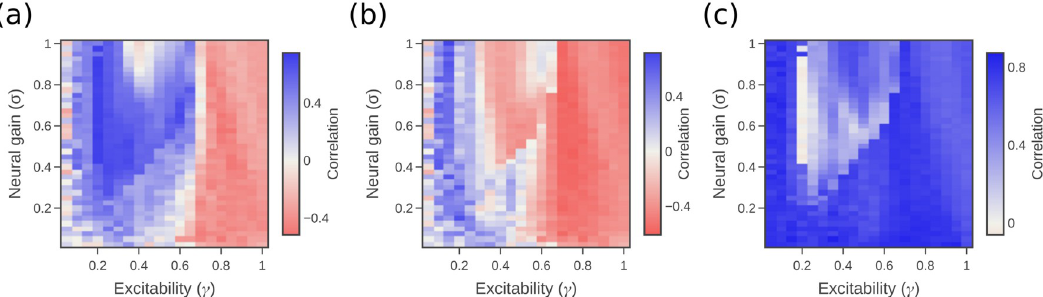
Fig 4. Correlations between information transfer and node degrees. (a) Correlation between TE rate and source in-degree. (b) Correlation between conditional TE rate and source in-degree. (c) Correlation between collective TE rate and target in-degree. Matching scale is used across all